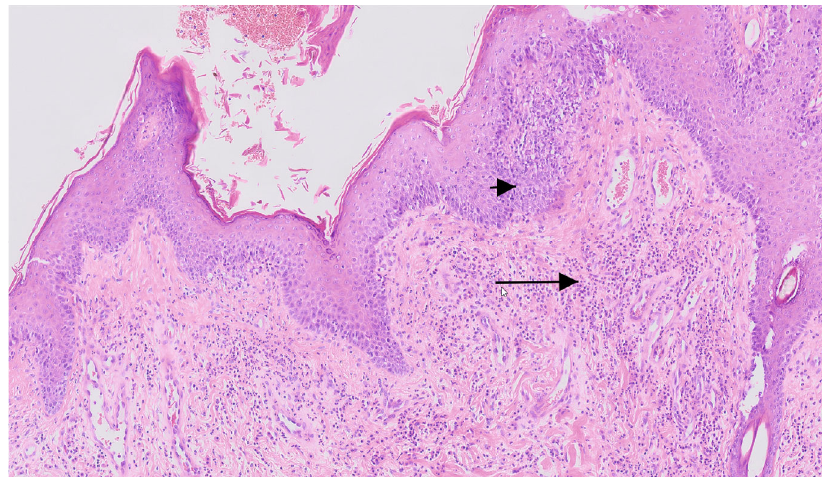
Figure 3: Hematoxylin and eosin photomicrograph ( × 10) showing epidermal hyperplasia (arrowhead) and eosinophils and mast cells in the dermis (arrow) (courtesy of IDEXX